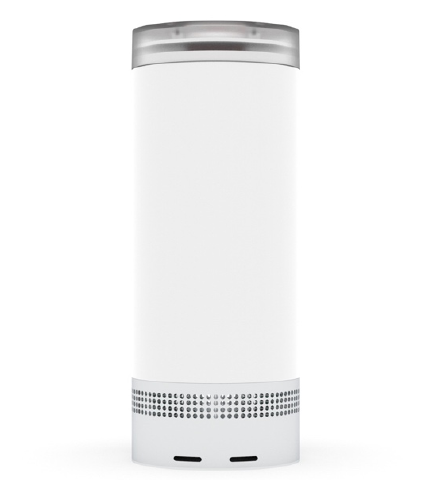
Figure 2. The MONTEM CityProbe. The height of the probe is 192 mm and the diameter 75 mm. It is made from hard plastic and light metals and weighs 558 g. The power supply comes from a solar panel attached by a